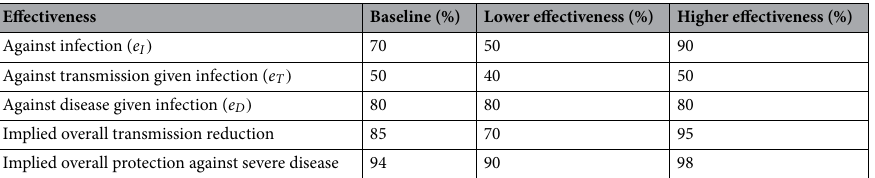
Table 1. Vaccine effectiveness parameters. These are chosen to reflect estimates of the effectiveness of the Pfizer-BioNTech mRNA vaccine after 2 doses 24 . The lower effectiveness parameters represent a potential SARS- CoV-2 variant of concern that partially evades immunity provided by the Pfizer vaccine. See Supplementary Information sec. 3 for more details. The overall reduction is transmission is given by 1 − ( 1 − e I )( 1 − e T ) , and the overall protection against severe disease is 1 − ( 1 − e I )( 1 − e D )